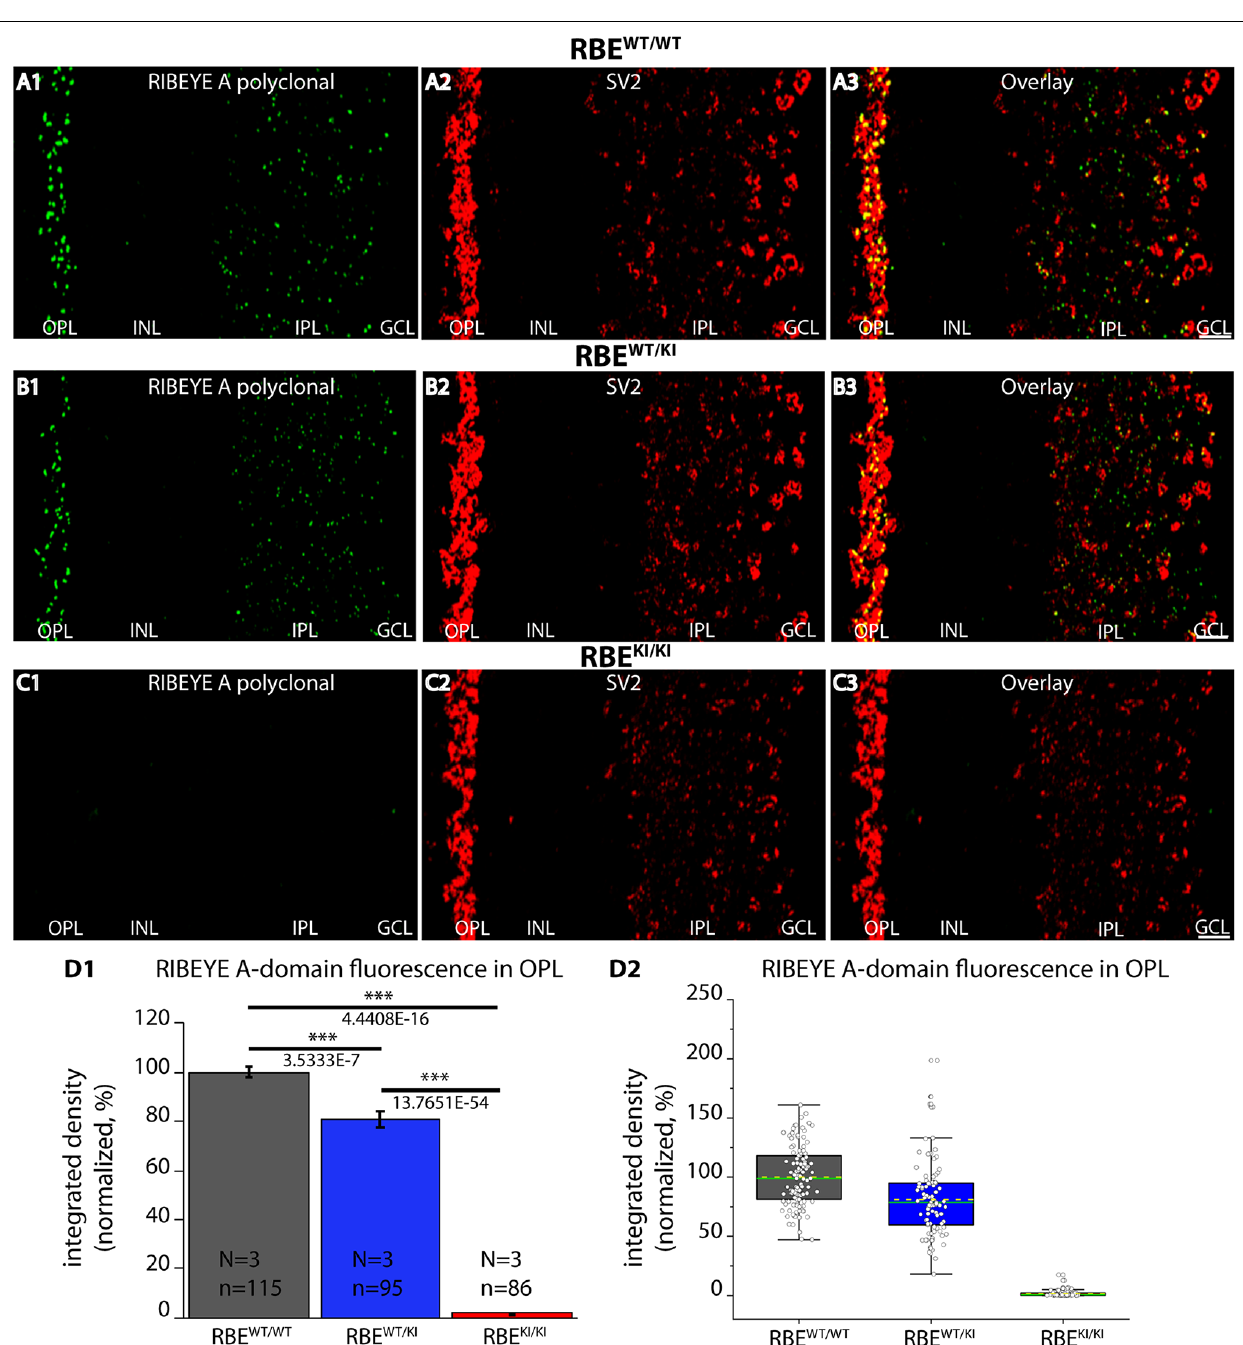
Frontiers in Molecular Neuroscience |